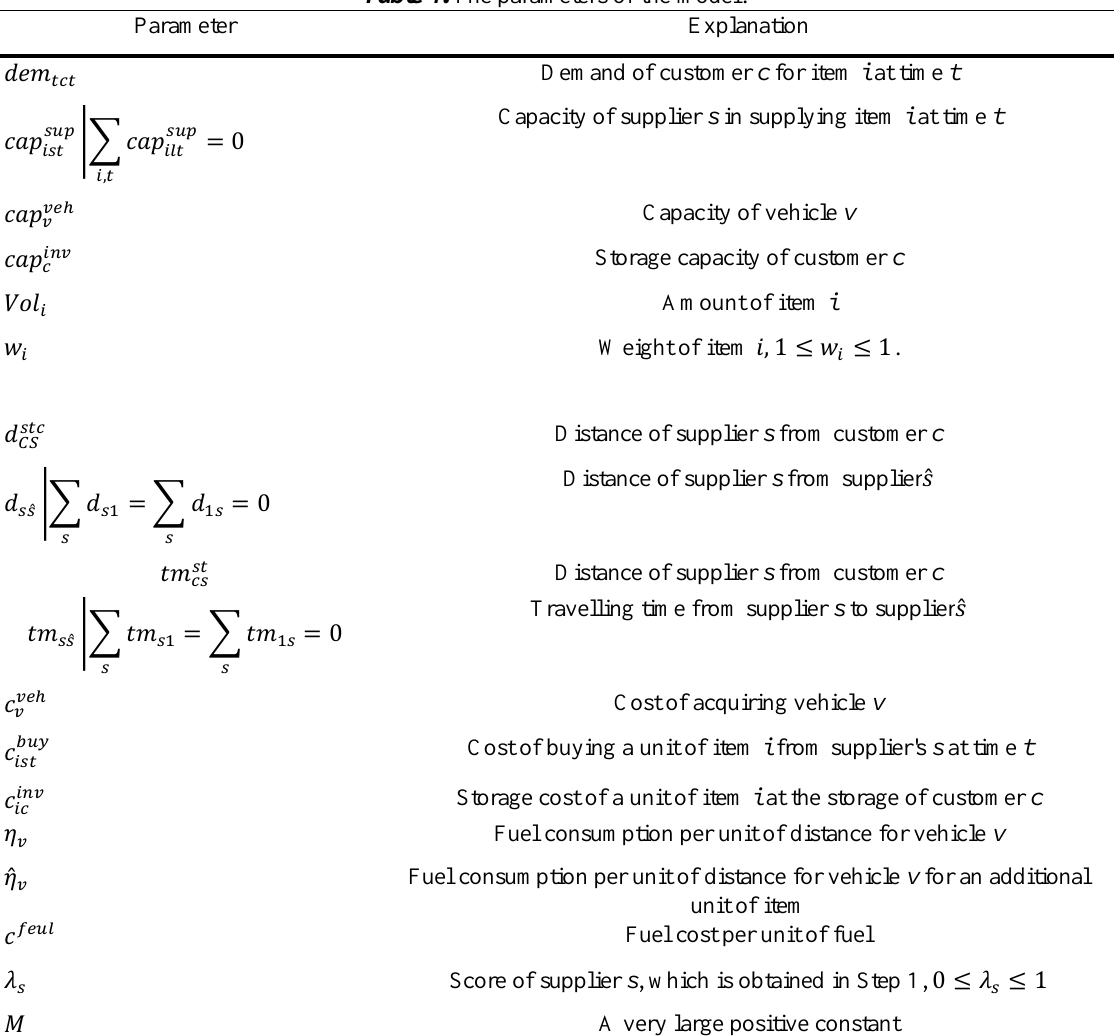
Table 4. The parameters of the